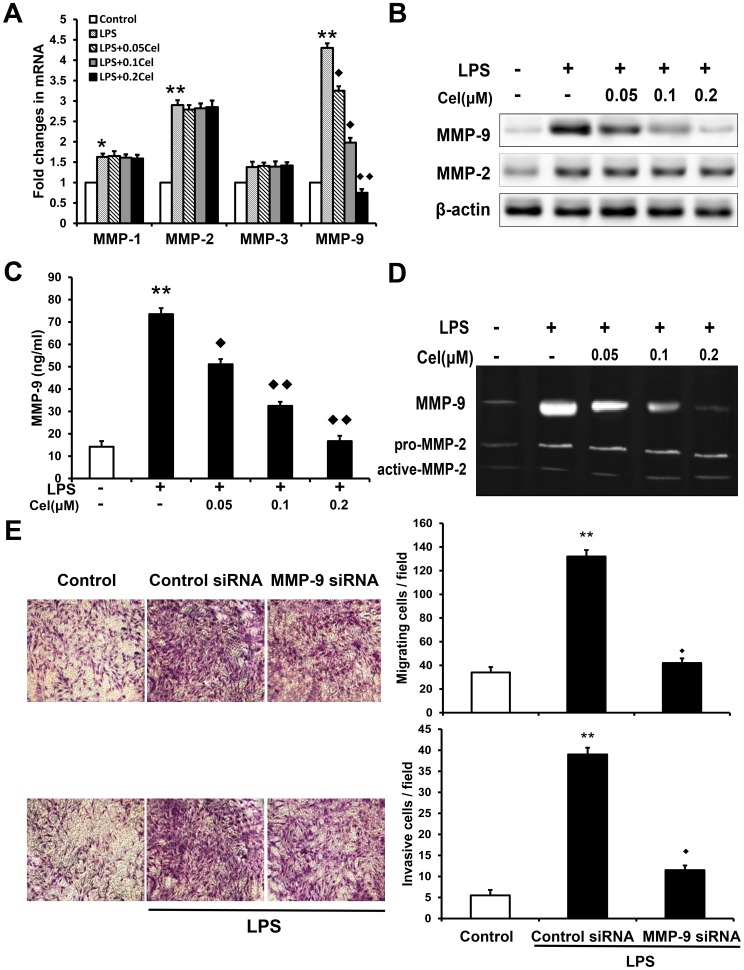
Celastrol inhibits LPS-induced RA-FLS migration and invasion by suppression of MMP-9 activity.FLSs were incubated with the indicated concentrations of celastrol for 24 h followed by LPS (1 µg/mL) stimulation. A and B: After 24 h, the mRNA and protein levels of endogenous MMP-1,2,3,9 were measured by qRT-PCR and western blot. GAPDH and β-actin were used as the internal controls, respectively. The histogram shows the mRNA levels from three independent experiments. **
P<0.01 versus normal control group, ⧫
P<0.05, ⧫⧫
P<0.01 versus LPS alone-treated group. C and D: The supernatants were collected and assayed for the amount and activity of secreted MMP-9, by ELISA and gelatin zymography, respectively. The histogram shows the ELISA results from three independent experiments. **
P<0.01 versus normal control group, ⧫
P<0.05, ⧫⧫
P<0.01 versus LPS alone-treated group. E: MMP-9 siRNA was used to study of the role of MMP-9 in LPS-induced migration and invasion of FLSs. After transfection with MMP-9 siRNA or control siRNA for 48 h, and stimulation with LPS, FLSs were allowed to migrate for 24 h. Left, photomicrographs of cells that have passed through membrane (100× magnification). Right, the cell number per microscopic field was plotted (mean ± SD in three independent experiments) in the histogram. **
P<0.01 versus normal control group. ⧫
P<0.05 versus LPS and control siRNA treated group.